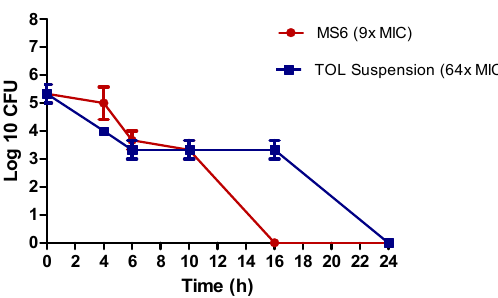
Figure 9. The killing kinetics of treatment A (MS6) and treatment B (TOL suspension) tested against Aspergillus niger (ATCC32656). Treatment A tested at concentration of (3.9 µ g/mL) (9 × MIC), treatment B (TOL suspension) tested at concentration of (125 µ g/mL) (64 × MIC). Data are represented by means of the number of recovered colonies counted at each time point ± SD, n = 3. The chart was generated using GraphPad Prism (v5) (GraphPad, California, CA, USA).